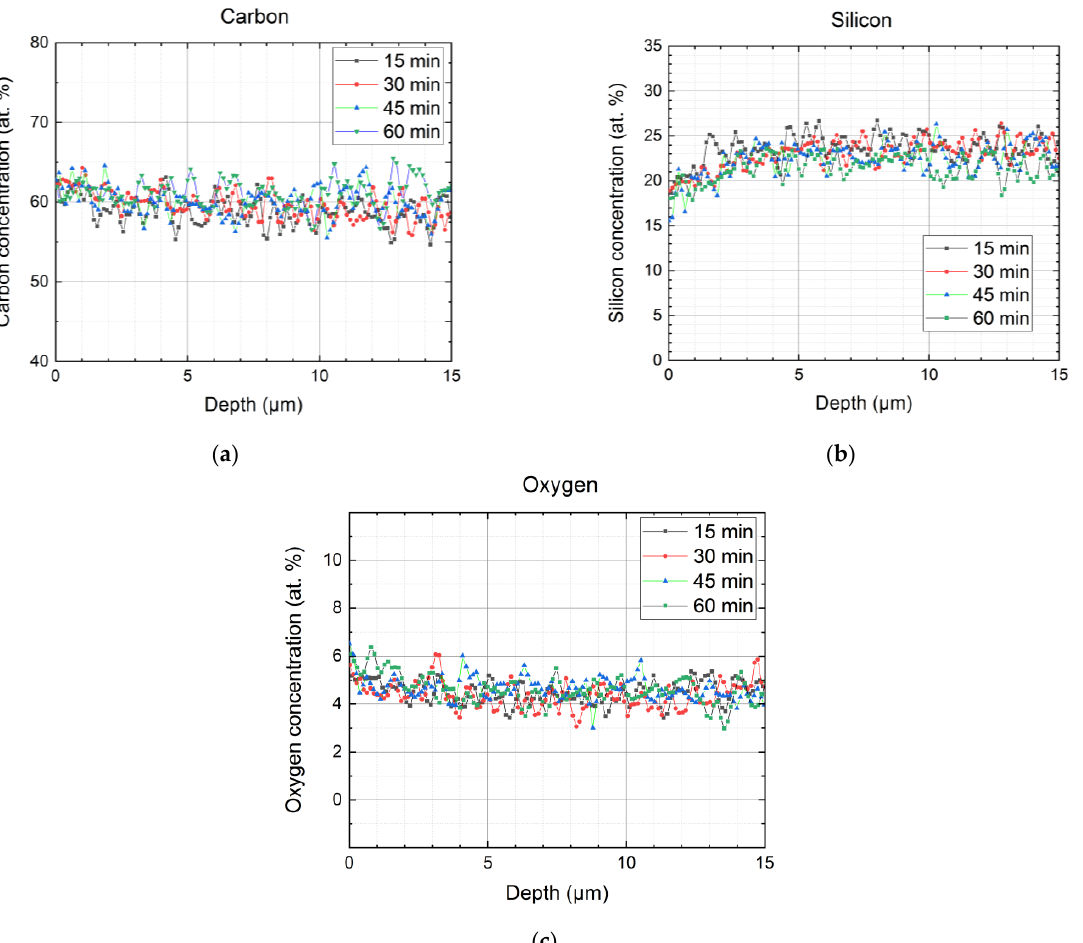
Figure 8. Carbon ( a ), silicon ( b ), and oxygen ( c ) content distribution over the thickness of the PVTMS samples fluorinated for 15, 30, 45, and 60 min.